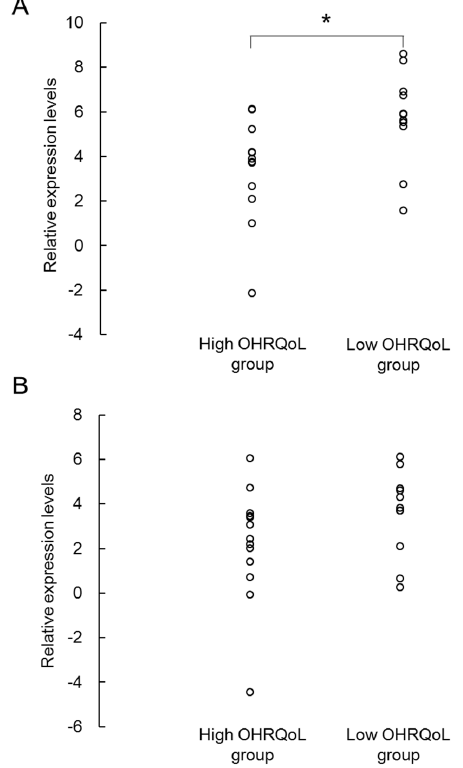
Figure 2. Differential relative expression levels of miR-203a-3p ( A ) and miR-30b-5p ( B ) obtained in the high- and low- oral health-related quality of life (OHRQoL) group. Circle plots represent relative expression rates of each sample. * p < 0.05, using the Mann–Whitney U test.